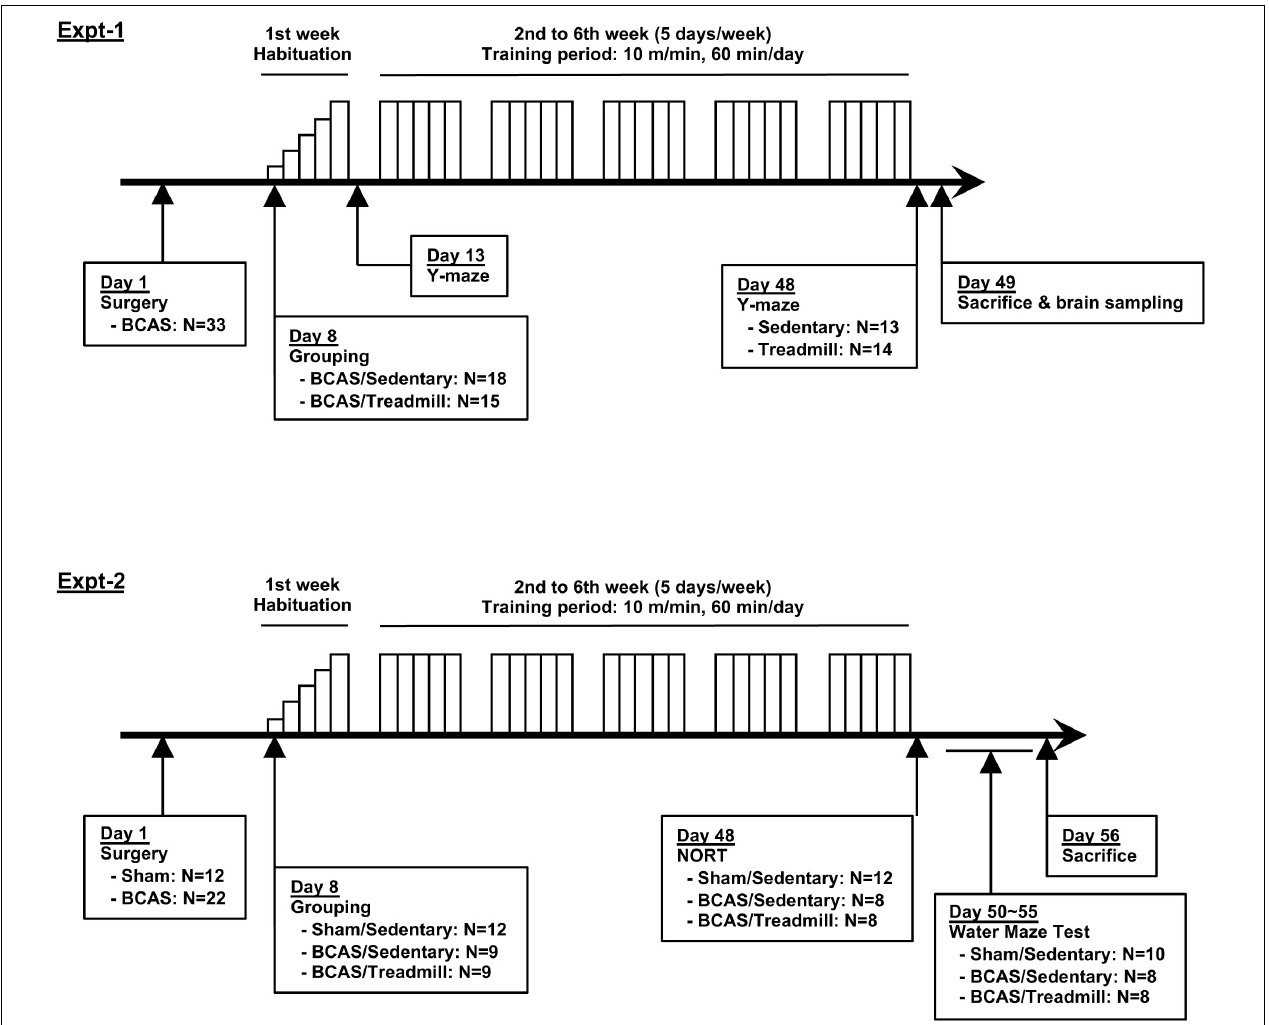
FIGURE 1 | Schematic overview of this study. Two experiments were conducted to examine the effects of treadmill exercise on the cognitive function of middle-aged hypoperfused SIVD-mice. BCAS mice were separated into 2 groups (Sedentary vs. Treadmill) 7 days after the surgery. Following a week-long habituation period (from day 8 to day 12), mice in the treadmill group were placed on a treadmill, on which they were obligated to run for 60 min/day at a maximum speed of 10 m/min on weekdays for 5 weeks. Y-maze was conducted 2 times, on day 13 and day 48 (Experiment 1). NORT was conducted 2 times, on day 48 (Experiment 2). The Morris water maze was conducted between days 50–55 (Experiment